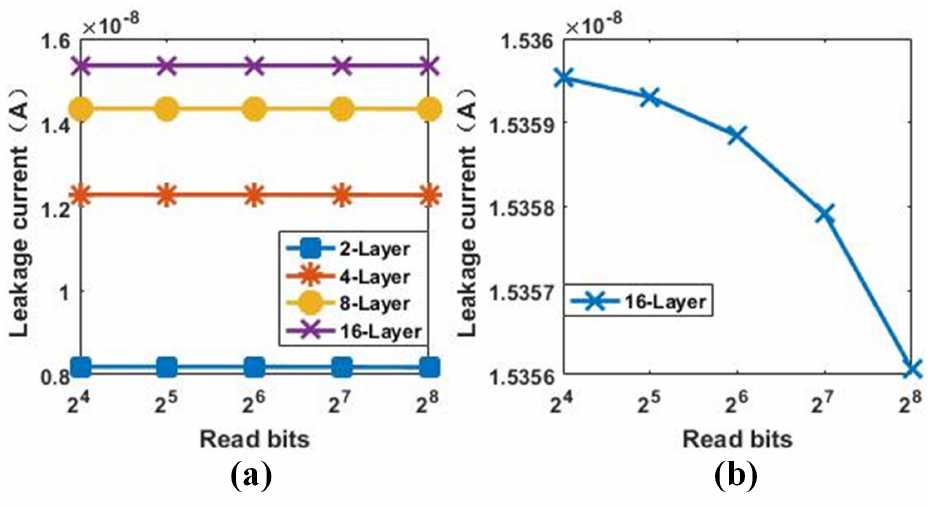
Figure 10. ( a ) The leakage current of multi-bit (from 2 4 to 2 8 ) parallel read under different layers (from 2 to 16), ( b ) the leakage current under various parallel reading bits when the number of stacked layers is 16 (planar array size is 256 × 256).